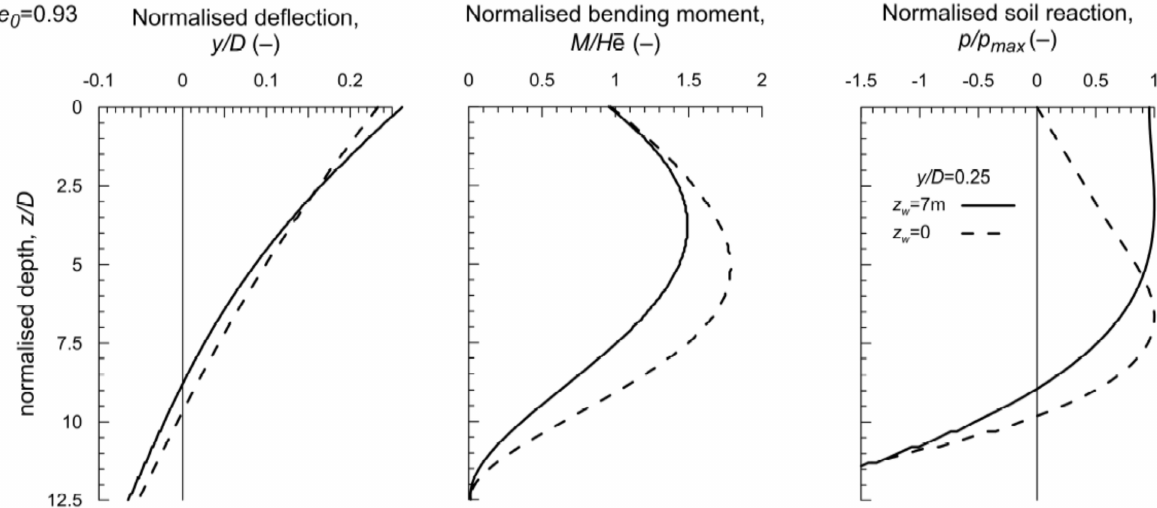
Figure 10. Pile response at large displacements ( y / D = 0.25), for the loose soil.